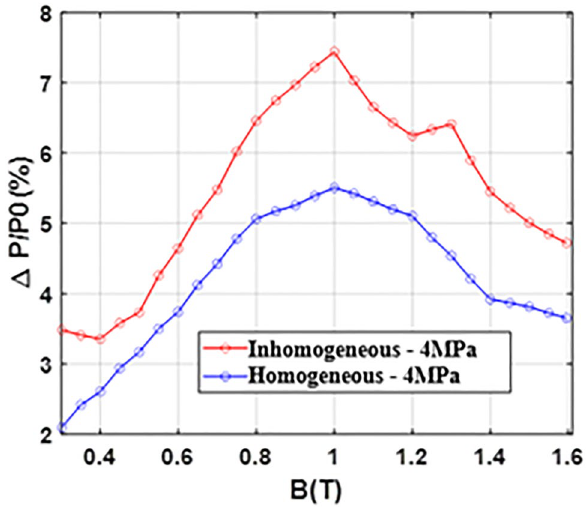
Figure 23. Relative evolution of iron losses - Homogeneous and inhomogeneous cases comparison.